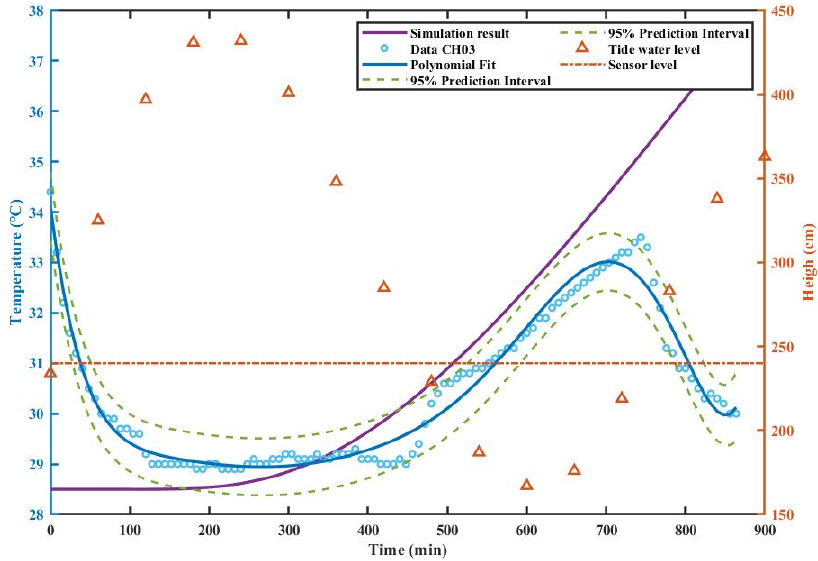
Figure 16. The relationship between the temperature value of node 3 and seawater tide level.